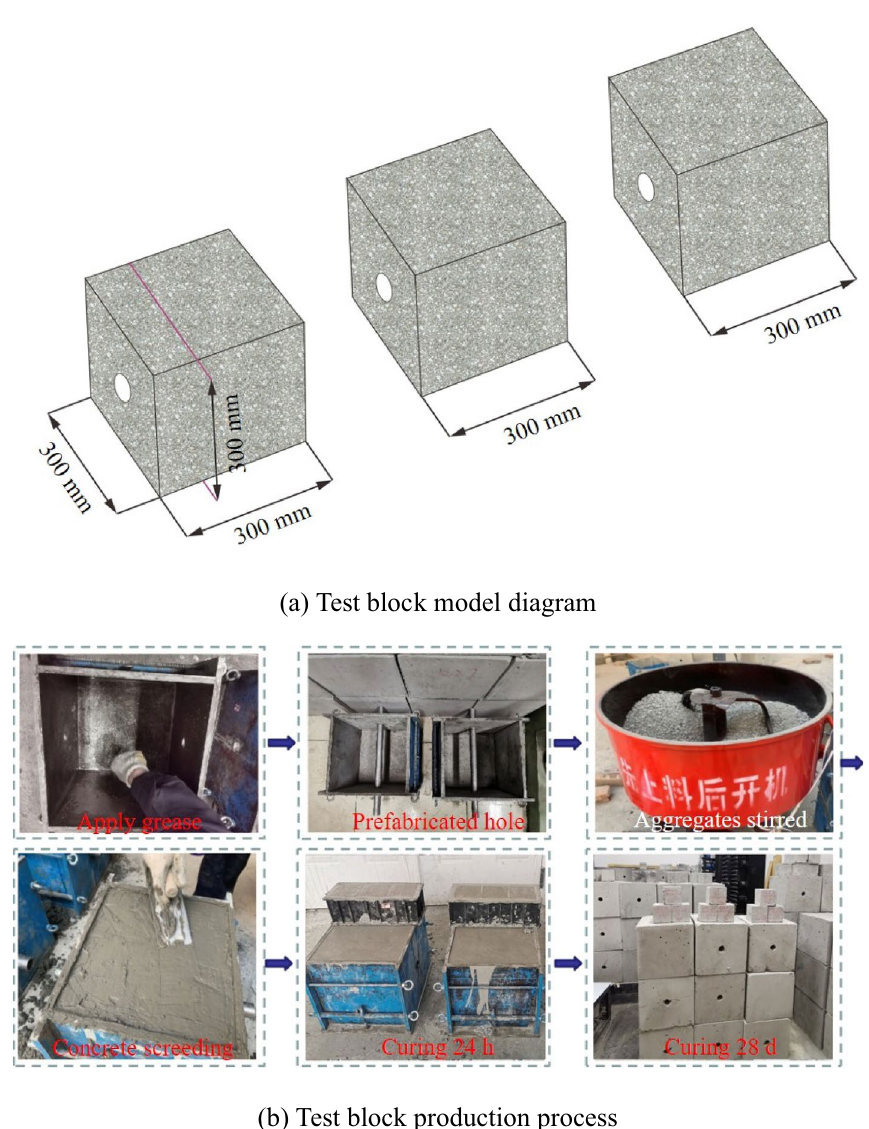
Figure 4. Dimensions and production process of anchored jointed rock mass model